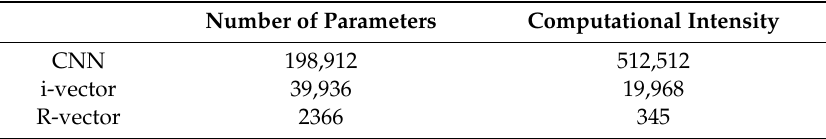
Table 10. Computation complexity of LID approaches for a two-class LID